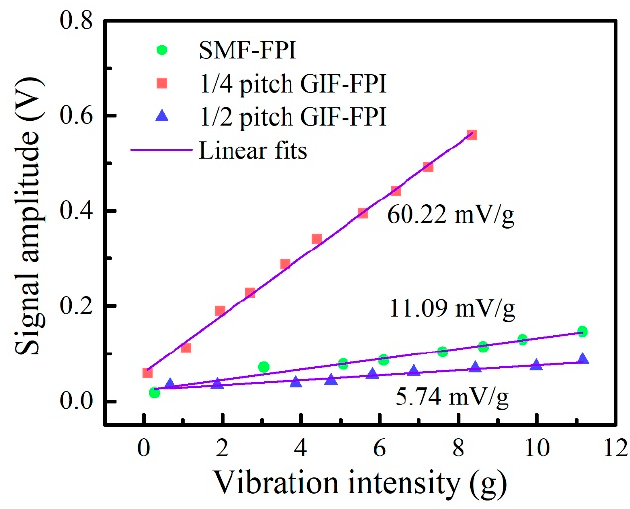
Figure 7. The linearity of the vibration responses of the SMF-FPI, the quarter-pitch GIF-FPI, and the half-pitch GIF-FPI with the same cavity length of 200 µ m at a vibration frequency of 100 Hz.